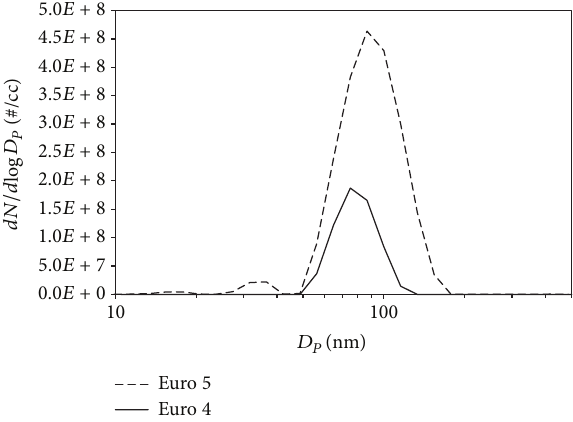
Figure 1: The particle size distribution function (PSDF) of diesel in the range